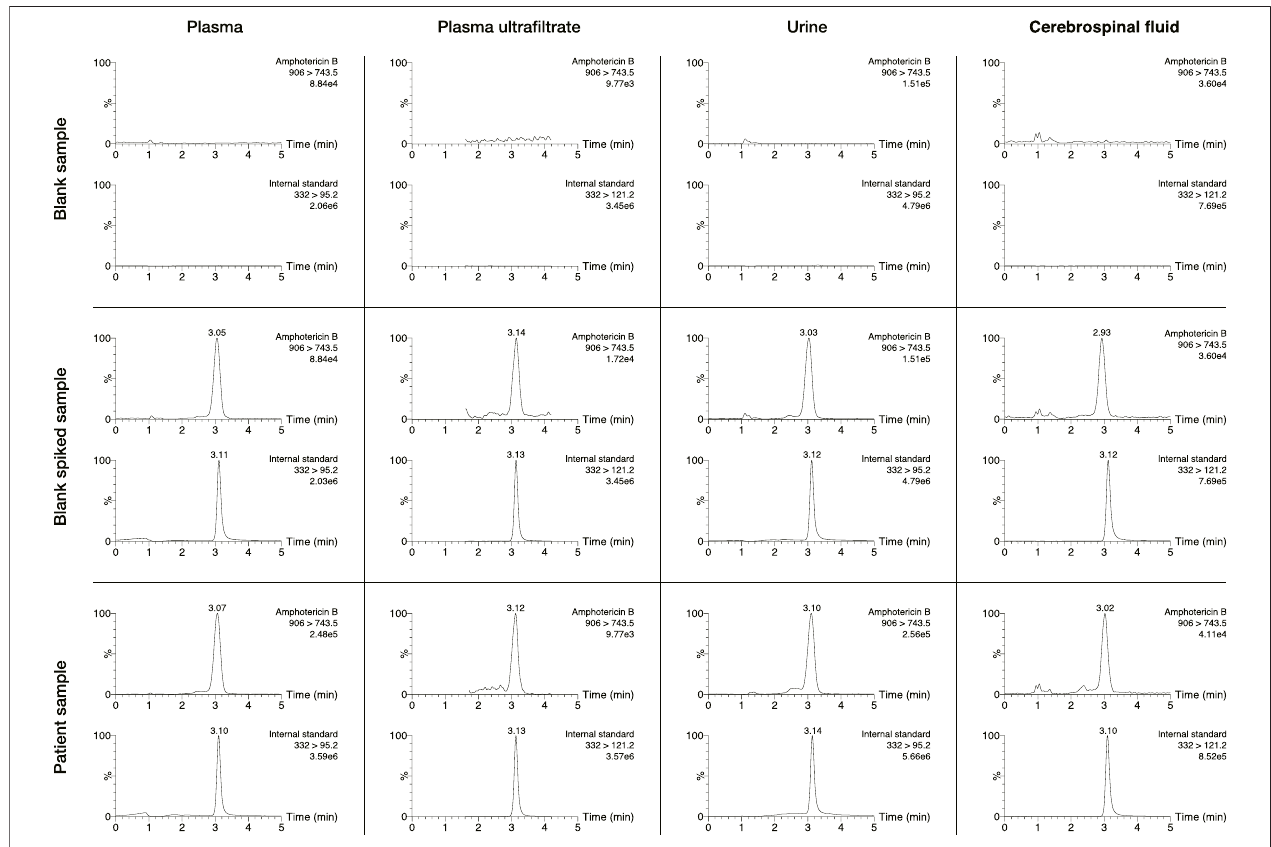
FIGURE 3 | Chromatograms of blank, spiked, and patient ’ s samples for human plasma, plasma ultra fi ltrate, urine, and cerebrospinal fl uid. The patient ’ s samples were enriched with the internal standard piroxicam.